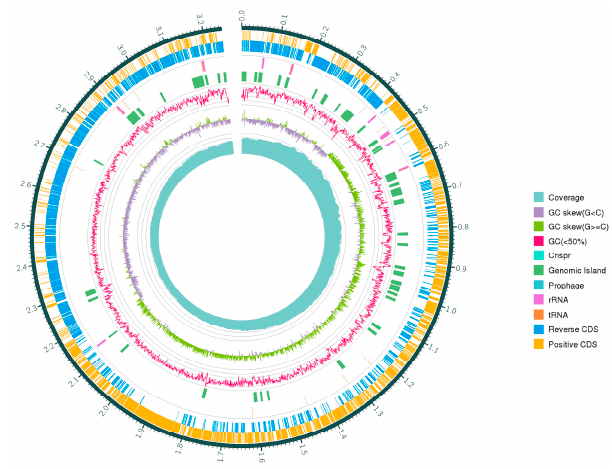
Figure 4. Circular genome map of W. coagulans PL-W. From outside to center, ring 1: encoding gene (positive CDS); ring 2: encoding gene (reverse CDS); ring 3: tRNA and rRNA; ring 4: CRISPR, prophage and genomic island; ring 5: GC content; ring 6: GC-skew; and ring 7: coverage. Table 2. General genome attributes of W. coagulans PL-W.